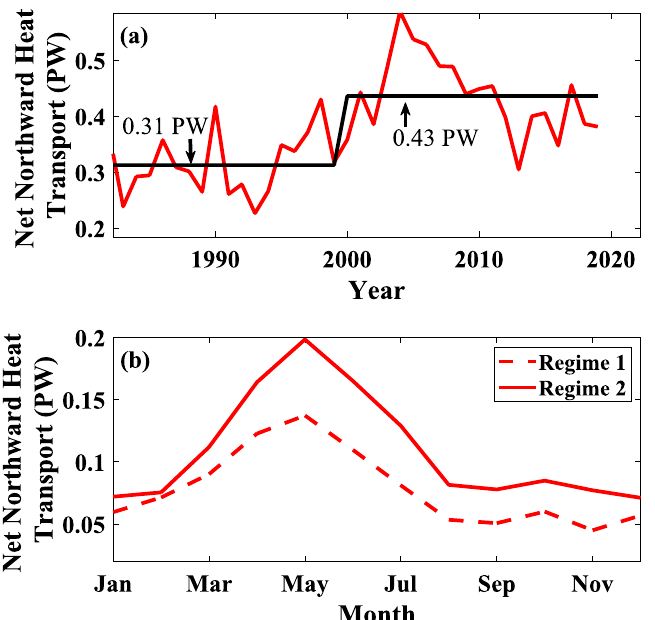
Figure 4. Net northward heat transport from Warm and Cold Core rings ( a ) shows the internal variability, ( b ) shows the seasonal variability, for before and after the regime shift in